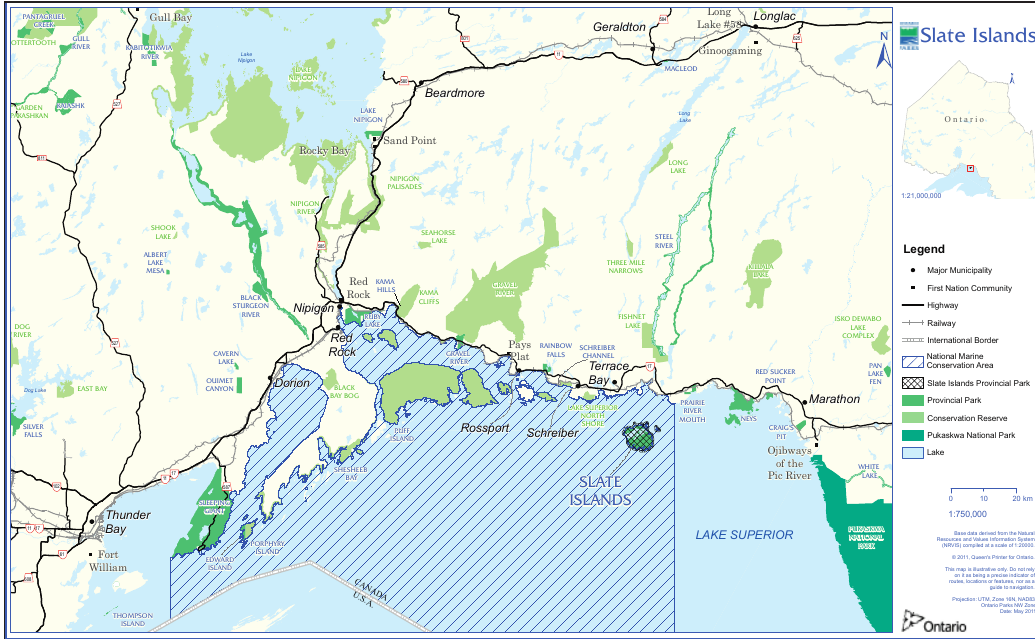
Fig. 1. Regional Context for Slate Islands Provincial Park.